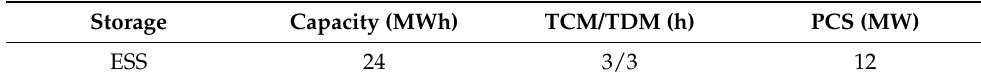
Table 2. Parameters associated with ESS Storage Capacity (MWh) TCM/TDM (h) PCS (MW) ESS 24 3/3